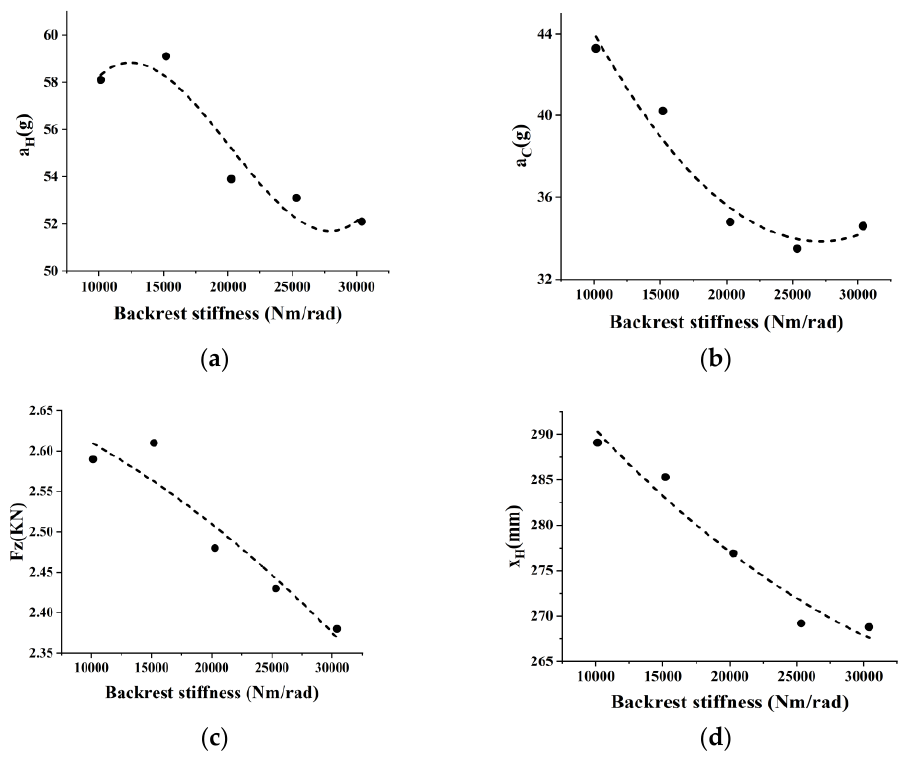
Figure 13. A value of 3 ms head resultant acceleration 𝑎 𝐻 variation ( a ), 3 ms chest resultant acceler- ation 𝑎 𝐶 variation ( b ), upper neck tension 𝐹 𝑍 variation ( c ), and the head horizontal displacement 𝑥 𝐻 variation ( d ) caused by the backrest stiffness adjustment.